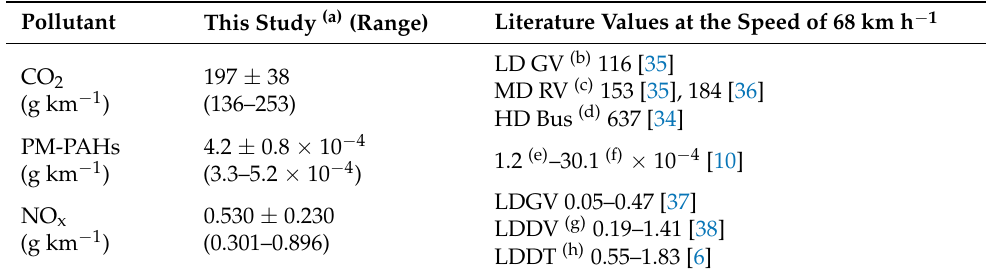
Table 3. Estimated emission factors of air pollutants by